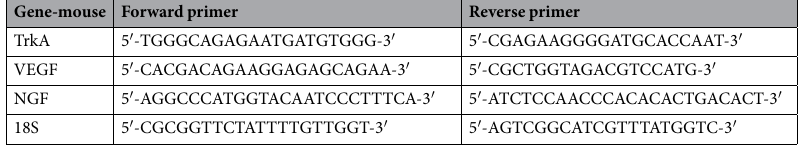
Table 1. For primer